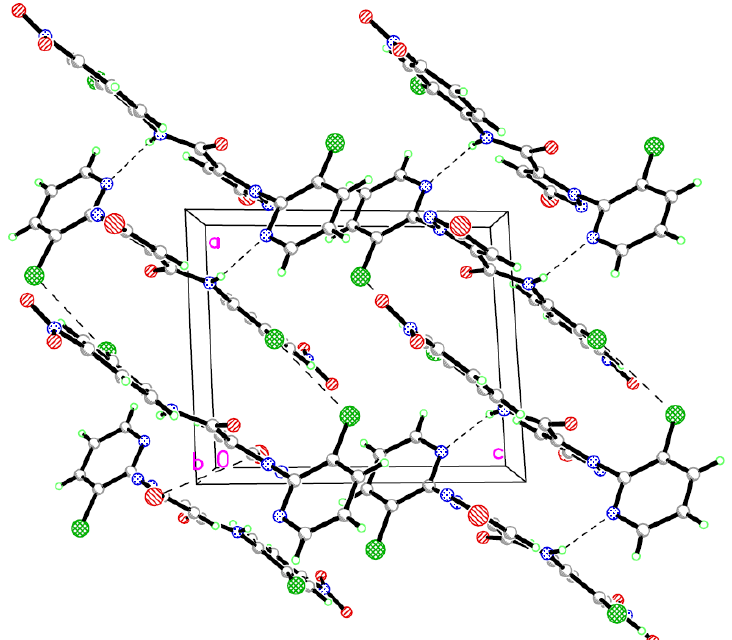
Figure 3. The packing of the molecules in the crystal lattice of 7l